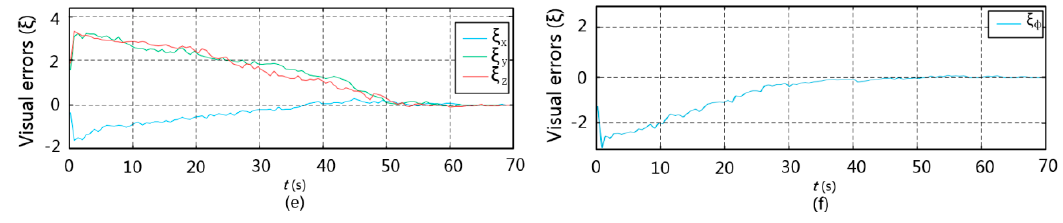
Figure 12. Linear velocities and angle velocity of experiment A.